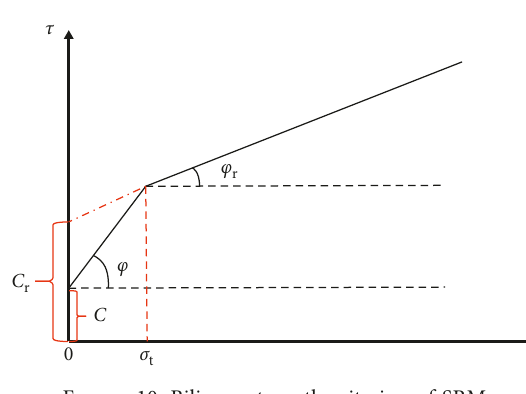
Figure 10: Bilinear strength criterion of SRM.